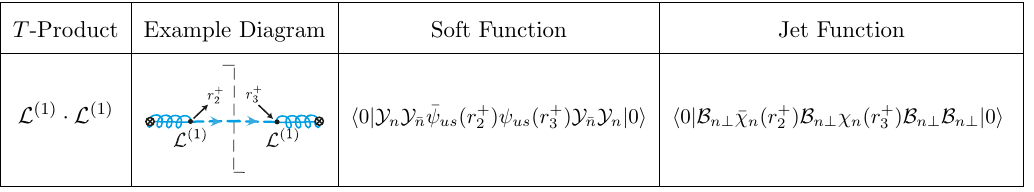
( (cid:21) 2 ) thrust cross section in gluon induced Higgs O (1) insertions. L